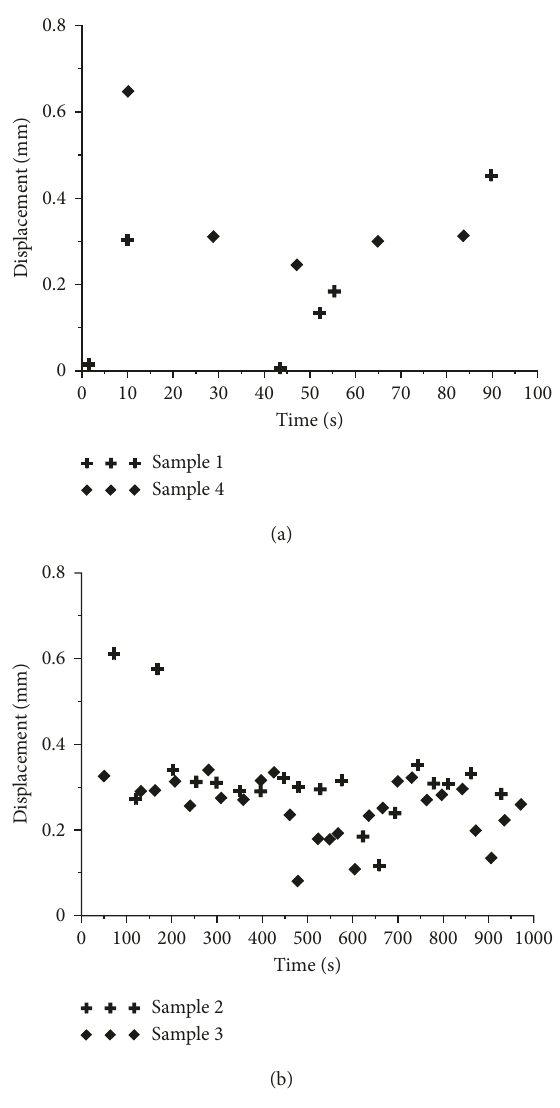
Figure 10: Displacement variations of Samples 1–4 during the statistical stick-slip periods. (a) Samples 1 and 4. (b) Samples 2 and 3.